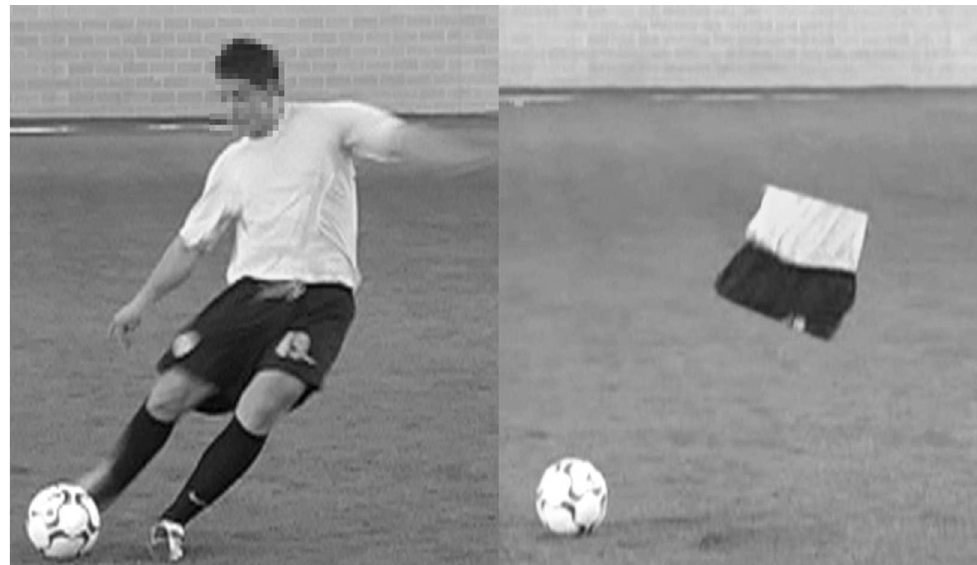
Fig 1. Ball contact for the full body condition (left) and hip region condition